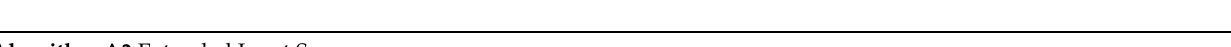
Algorithm A3 Extended Least